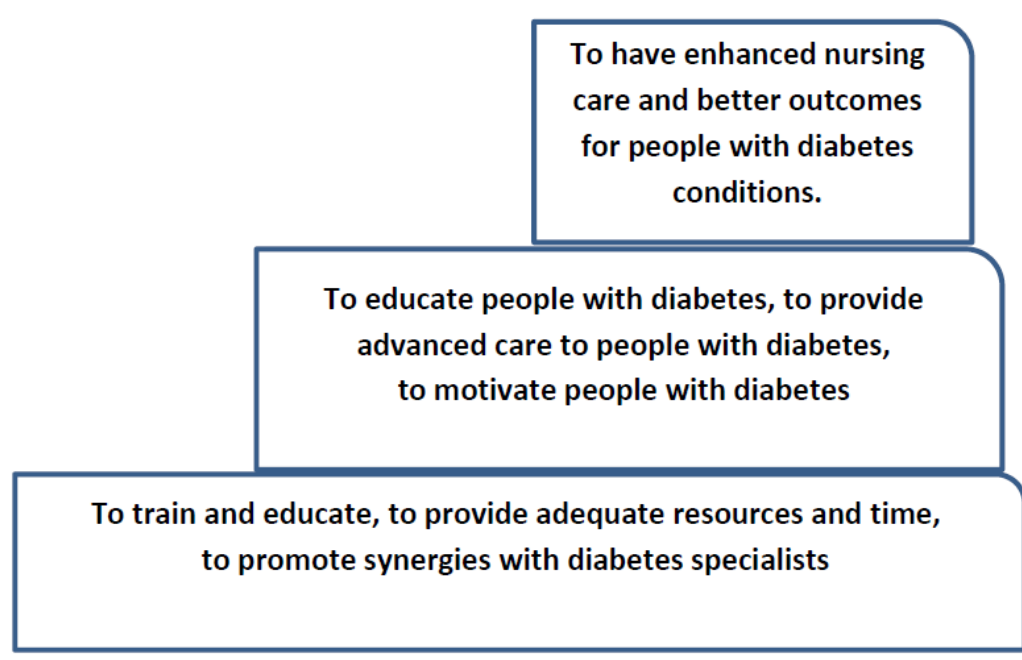
Figure 2. The stepladder model for achieving enhanced nursing care of people with